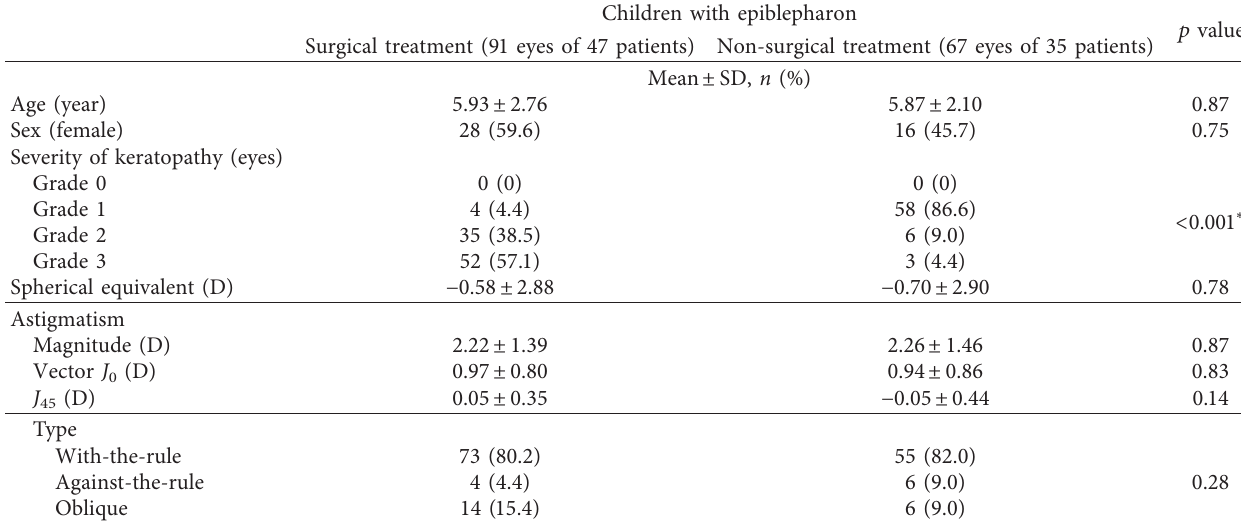
Table 1: Demographic data, symptoms, severity of keratopathy, and refractive status of the study population.